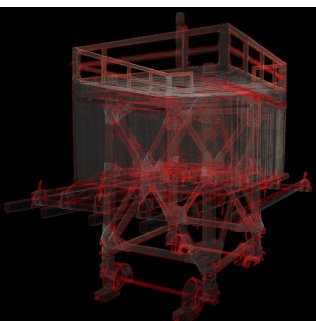
Figure 12. Opacity-based edge highlighting (type (b)) of a 3D scanned point cloud of the Hachiman-Yama float used in the Gion Festival in Kyoto City, Japan.